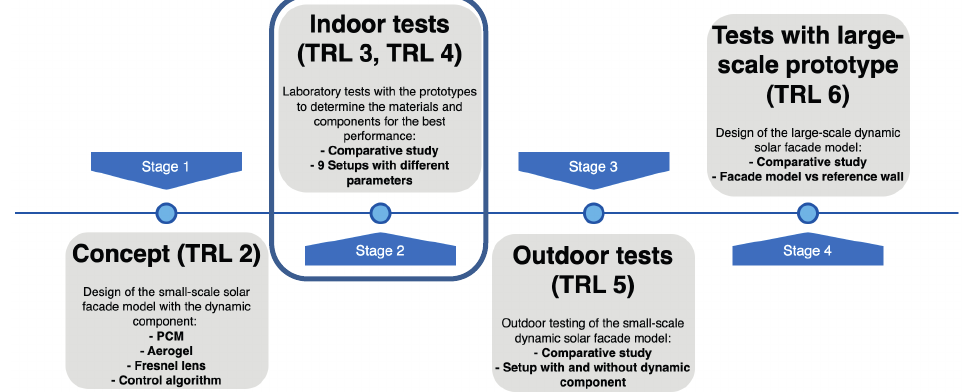
Fig. 1. Scope of the research (Stage 2) within the framework of the whole study [25]